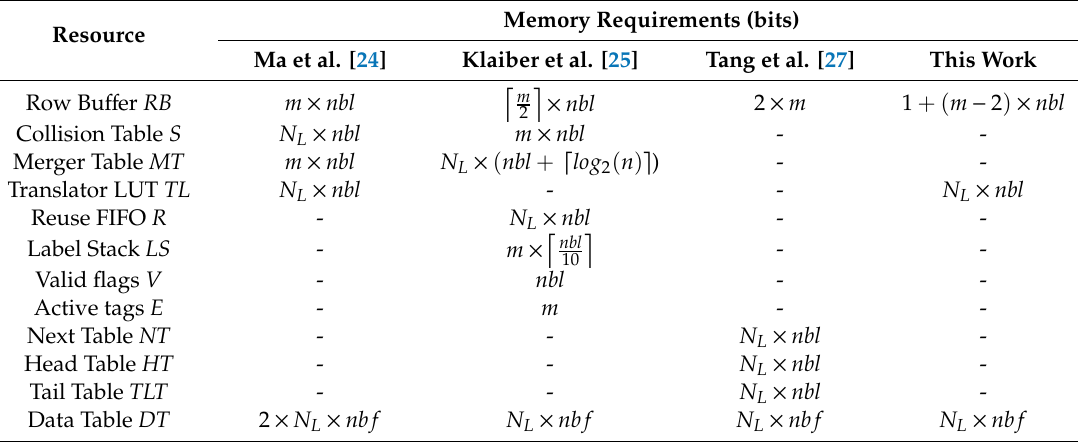
Table 2. Memory requirement of several CCA architectures processing n × m input images.